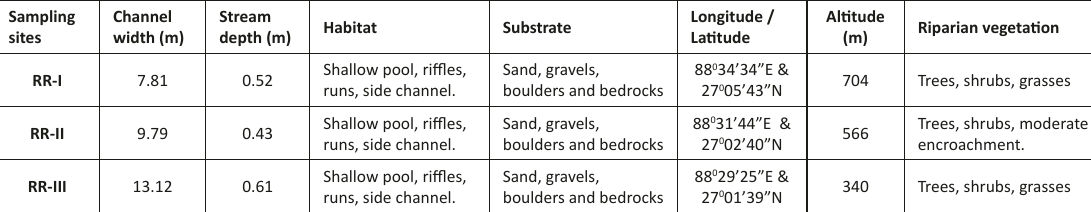
Table 1. Physical characteristics and channel morphology in the sampling sites of hill stream Sampling Channel Stream Habitat Substrate sites width (m) depth (m)